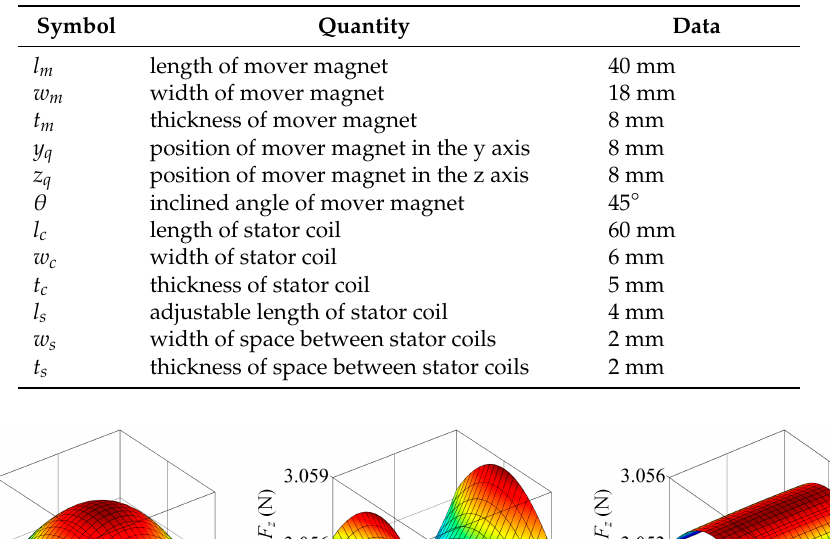
Figure 5. Structural parameters of the HMF-VCA. ( a ) 3-D view. ( b ) 2-D view. Table 1. Structural parameters of the HMF-VCA.